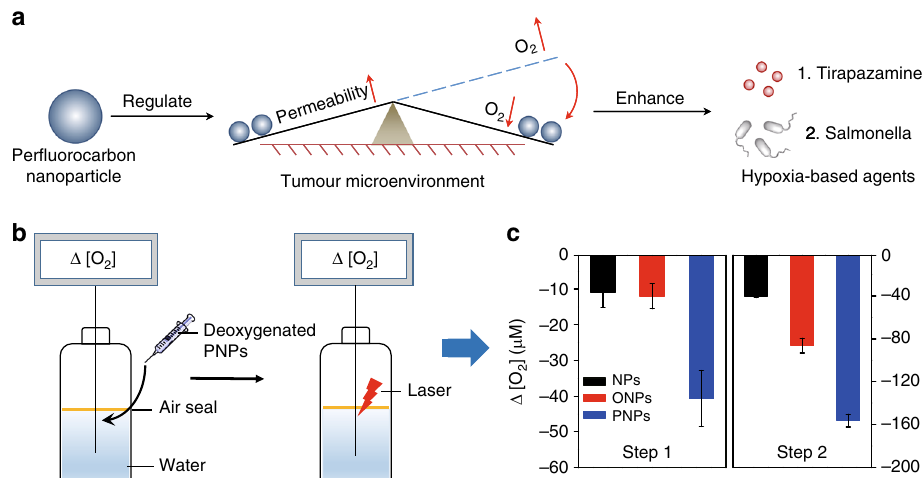
Fig. 1 A schematic diagram of PNP-mediated improvements in the function of HBAs and O 2 absorption and consumption by PNPs. a Schematic diagram of PNP-enhanced hypoxia-based drug ef fi cacy. PNPs enable both enhanced tumour permeability and long-term hypoxia to improve the ef fi cacy of HBAs. b Schematic illustration of the measurement of the O 2 absorption/consumption ability of the PNPs. Step 1: Deoxygenated samples were added to H 2 O sealed with oil; changes in DO (dissolved O 2, Δ [O 2 ]) were measured using an inserted O 2 probe. Step 2: Changes in DO before and after laser irradiation. c Quantitative determination of DO variations in steps 1 and 2 ( n = 3). Data are presented as the mean ± s.e.m. Source data are provided as a Source Data